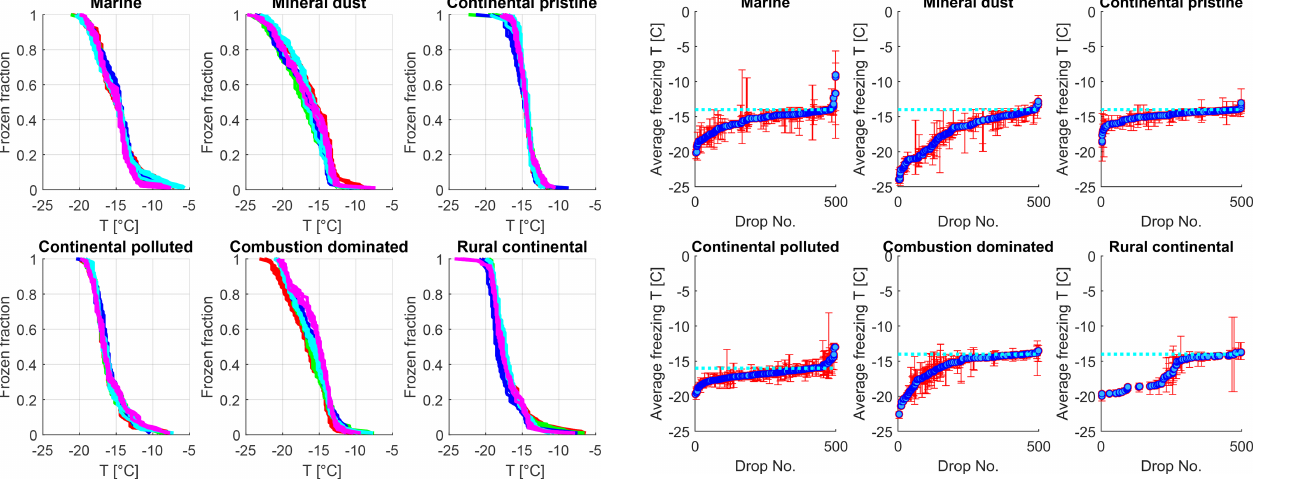
Figure 7. Frozen fraction as a function of cold-stage temperature for the six samples measured at constant cooling rate (2Kmin − 1 ) (six panels: marine, mineral-dust-influenced, continental pristine, continental polluted, combustion-dominated and rural continental samples). Each colour represents one of five different drop popu- lations from any given sample exposed to the same cooling cycle starting at − 5 ◦ C. For each drop population, at least four curves of the same colour are shown, each representing experiments at differ- ent times before, between and after the isothermal periods (2–16h) regarding each panel. The time resolution of the imagery was 5s which limits the accuracy of the determination of the freezing tem- perature ( ± 0 . 1K).